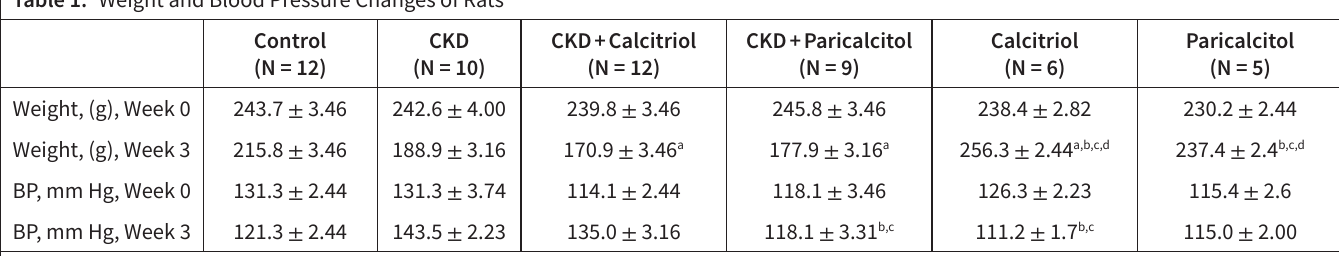
Table 1. Weight and Blood Pressure Changes of Rats